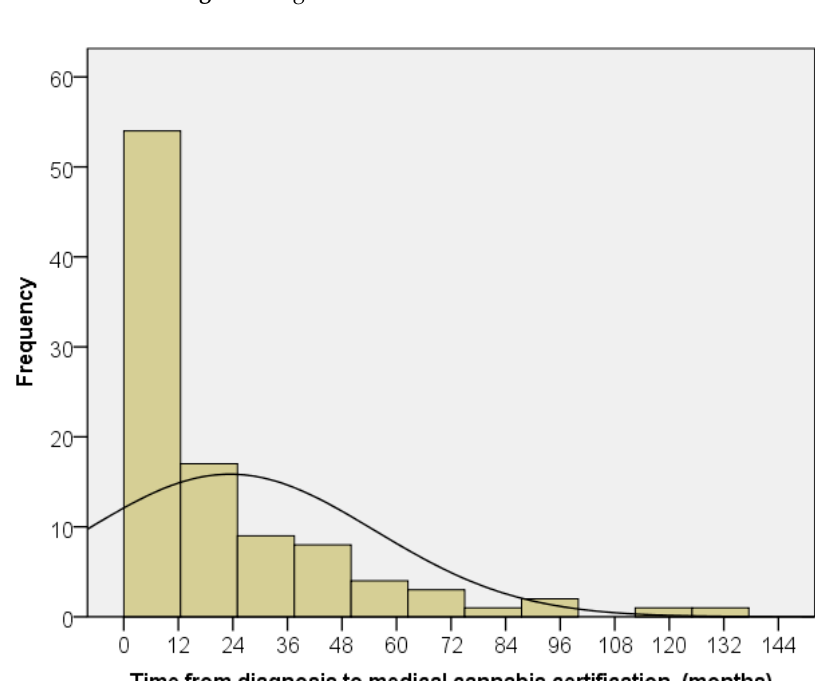
Figure 2. Time from cancer diagnosis to medical cannabis certification.